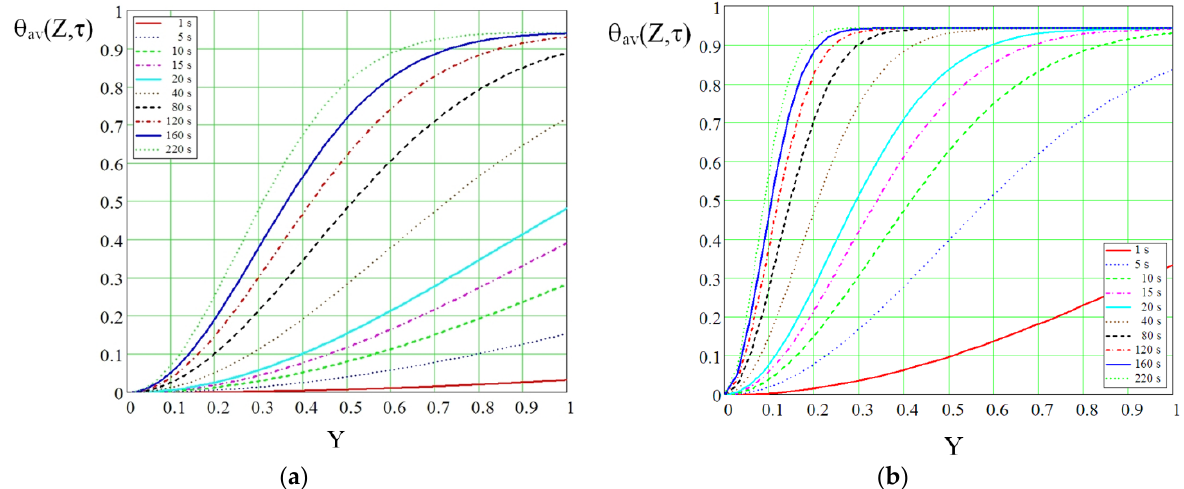
Figure 13. Evolution of the mean dimensionless temperature over time: ( a ) without heat source at the vaporizer, ( b ) with heat source at the vaporizer.